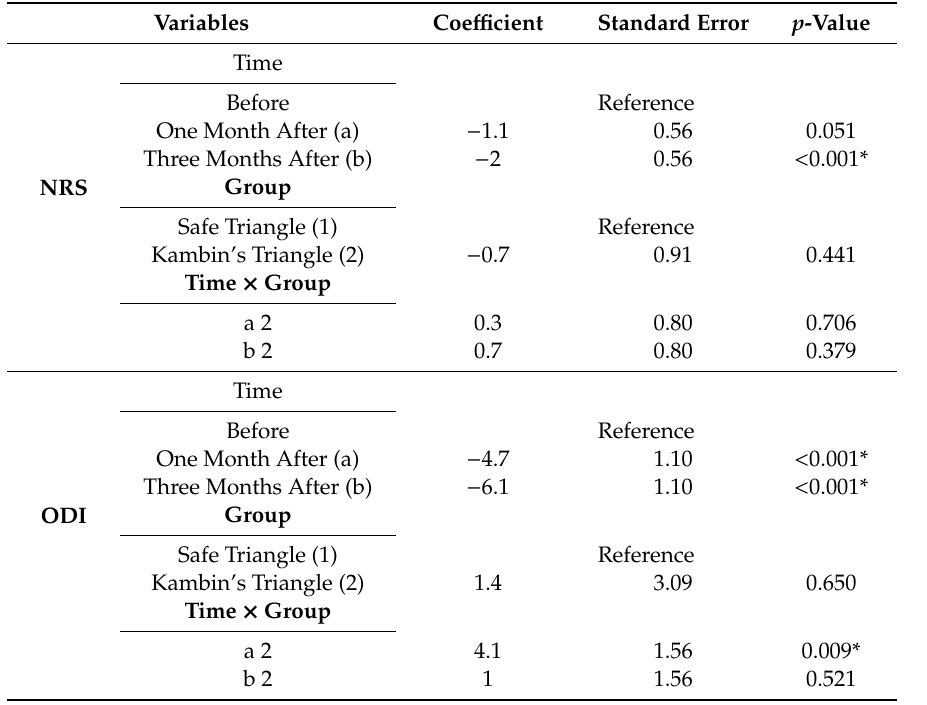
Table 4. An analysis of the Numerical Rating Scale and Oswestry Disability Index scores before and after the procedure in the safe-triangle-approach and Kambin’s-triangle-approach groups using a linear mixed